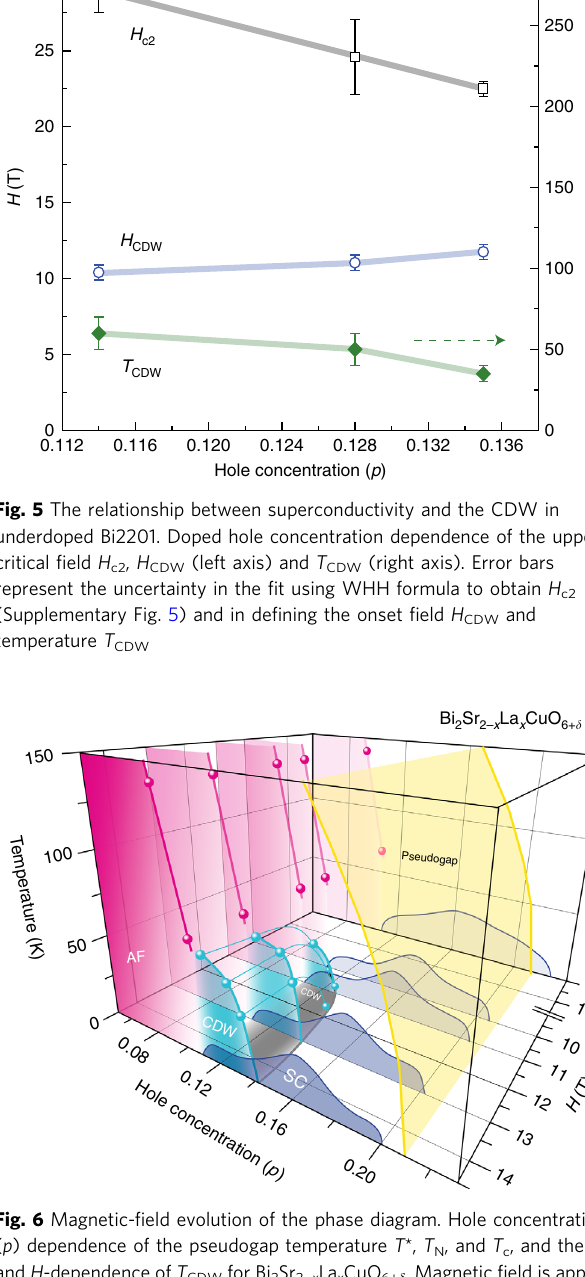
Fig. 6 Magnetic- fi eld evolution of the phase diagram. Hole concentration ( p ) dependence of the pseudogap temperature T *, T N , and T c , and the p - and H -dependence of T CDW for Bi 2 Sr 2 − x La x CuO 6+ δ . Magnetic fi eld is applied along the Cu-O bond direction ( H k a ð b Þ ). T CDW ( p , H ) (green and gray curves) is obtained from the results on Fig. 1f and Fig. 4. T * (yellow curve) and T N (red curve) are from the previous works 5,18 . T c ( p , H ) (blue curve) is determined by the ac-susceptibility measurements using the NMR coil broadening function, a two-peak structure can be reproduced. In such case, the quantity 2 δν corresponds to the CDW order parameter 28 . We emphasize that the value of δ p is twice larger than that observed in YBCO 19 , indicating that a larger CDW amplitude is realized in Bi2201. This difference may arise from the different crystal structure between the two systems. YBCO is a bi-layer system while Bi2201 is single layered. When CDW has a different phase between two CuO 2 planes, the ordering effect would be weakened or even canceled out.